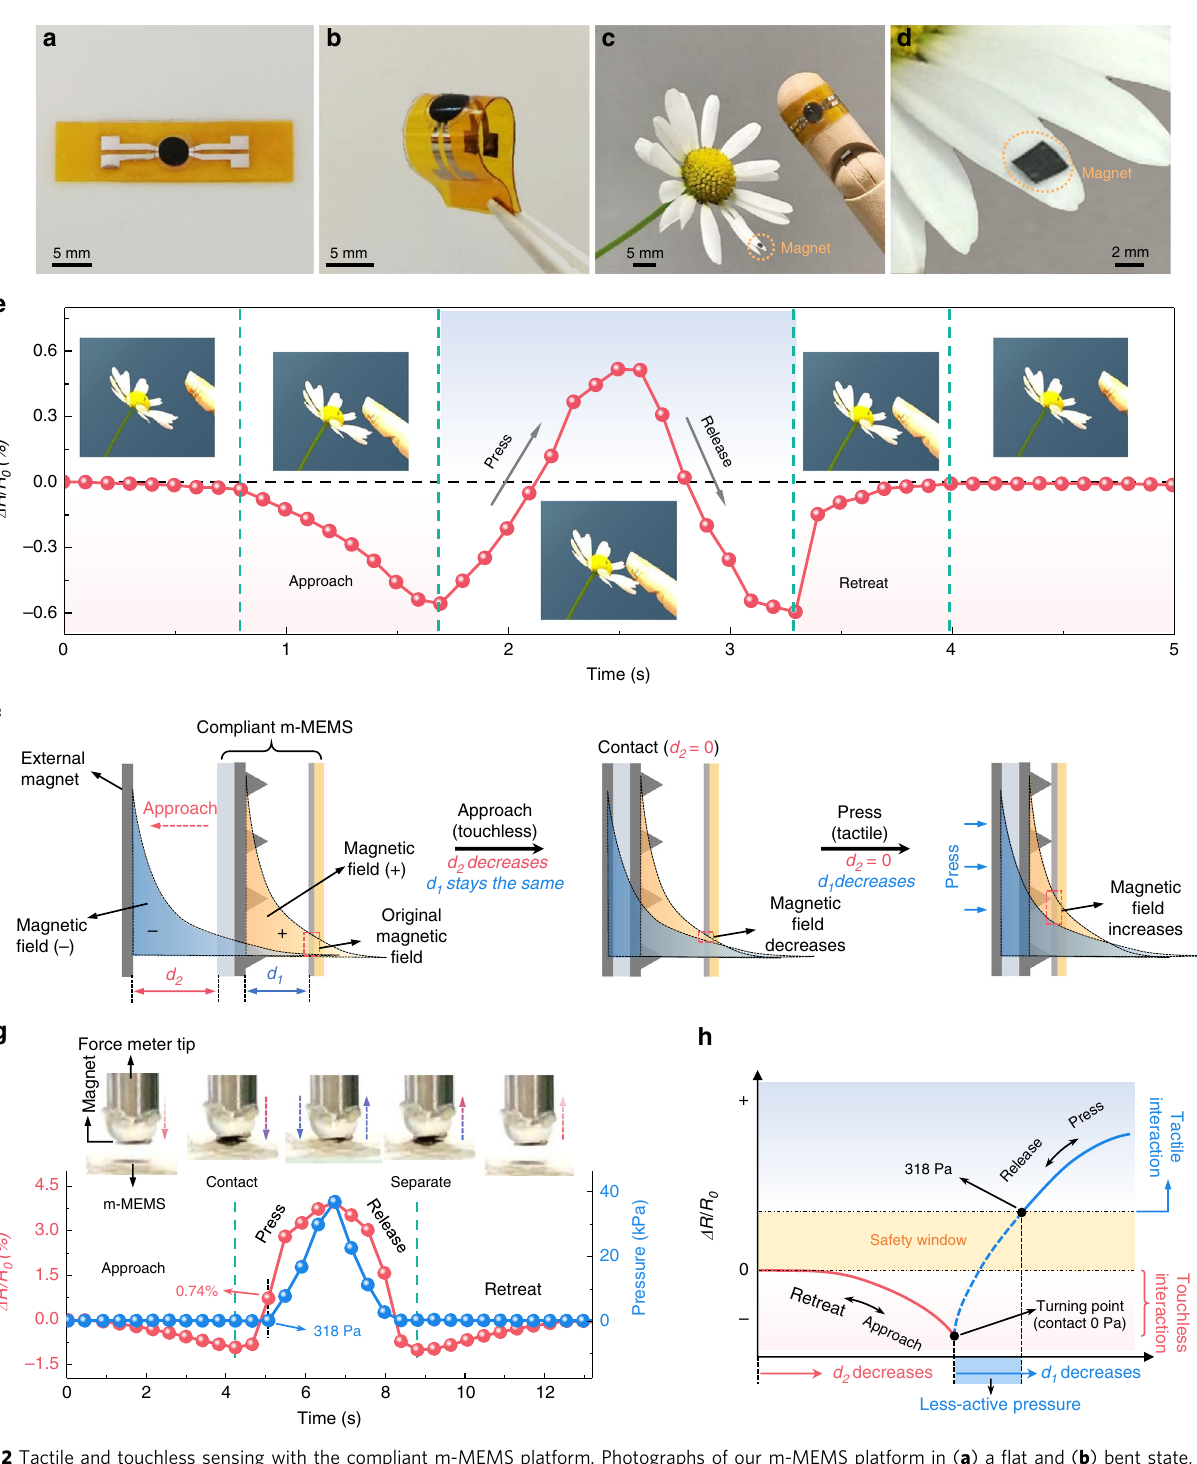
Fig. 2 Tactile and touchless sensing with the compliant m-MEMS platform. Photographs of our m-MEMS platform in ( a ) a fl at and ( b ) bent state. c A photograph of the MEMS platform wrapped around a wooden model fi nger. d A petal of a daisy fl ower decorated with a 20- μ m-thin compliant permanent magnet (magnetized by 2.3 T, Supplementary Fig. 5). e Change of the electrical resistance ( Δ R / R 0 ) upon an interaction event where the fi nger bearing the m-MEMS platform approaches, touches and retreats from the magnet-decorated fl ower petal. The distance between the m-MEMS platform and the external permanent magnet is 4 mm. f Schematic illustration of the evolution of the strength of the magnetic fi eld at the sensor location: superposition of the built-in magnetic fi eld provided by the compliant permanent magnet (orange-shaded region) and an external magnetic fi eld source (blue-shaded region). g Change of the electrical resistance (red dots) and the corresponding mechanical force (blue dots) applied to the m-MEMS during approaching, touching, pressing, releasing and retracting. h Schematic illustration of the safety window that separates the signal of the touchless interaction from the one of the tactile